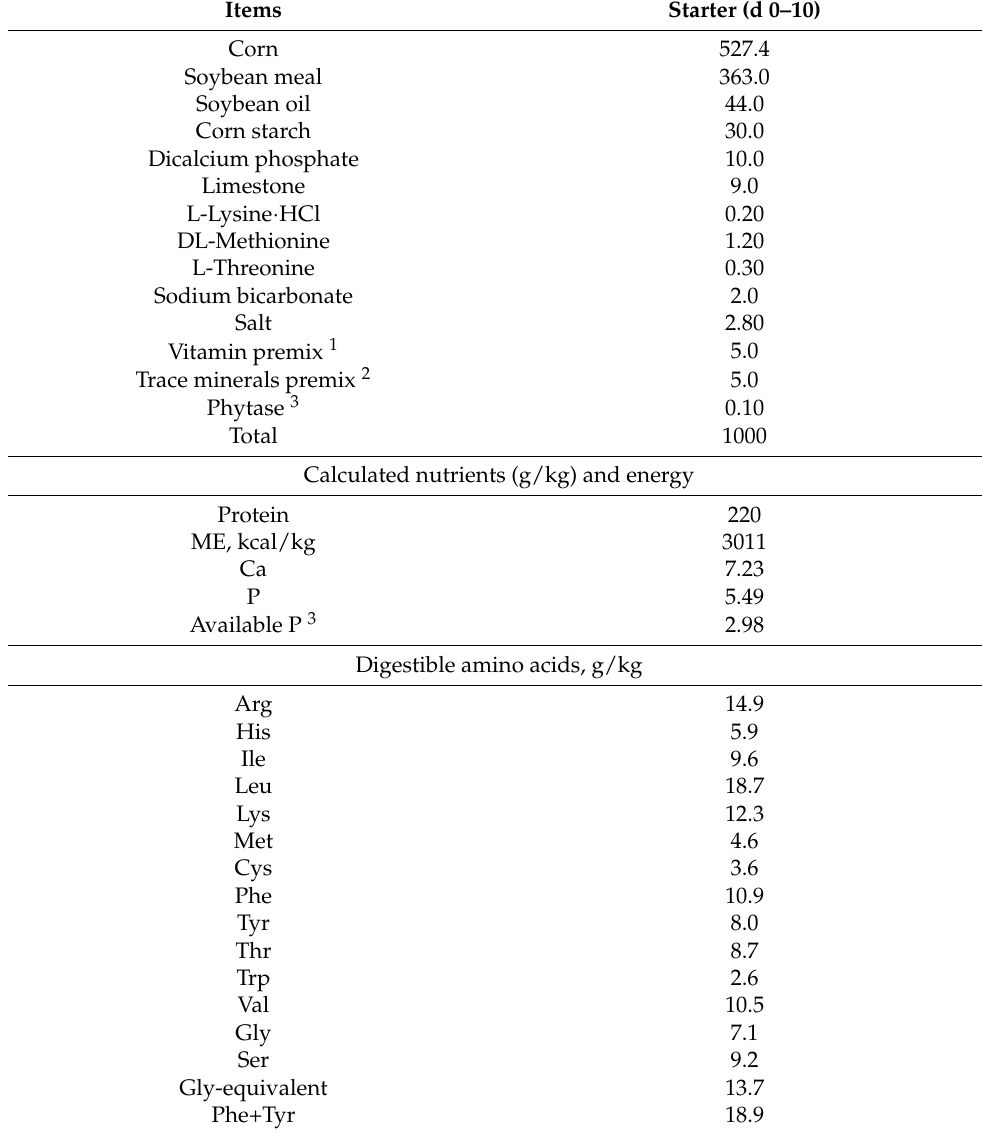
Table 2. Ingredient and chemical compositions (g/kg) of starter diets (day 0 to